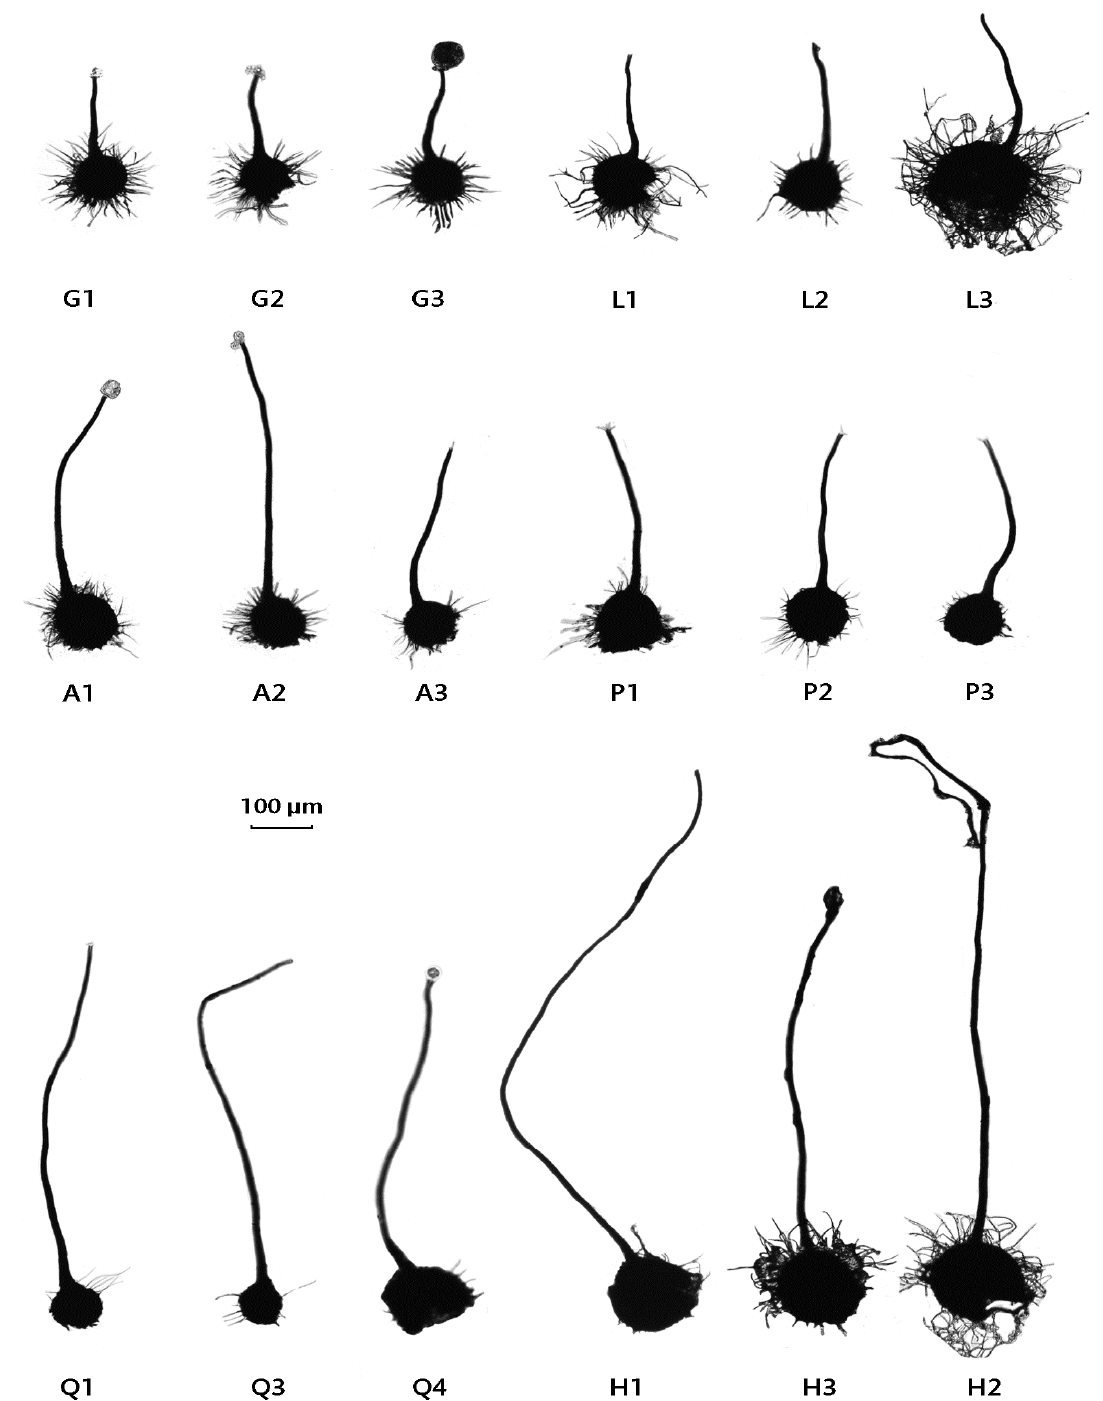
Figure 5. Perithecia of Orvieto and Limburg hybrids. Top row, random perithecia of short-necked, more SSAM-like Limburg and Orvieto pairings, G and L, respectively; Middle row, random perithecia of more SSNU-like Limburg and Orvieto pairings, A and P, respectively; bottom row, random perithecia of extreme long necked Orvieto and Limburg pairings, Q and H, respectively. Scale bar = 100 µ m. Some perithecial bowls are adorned with setae. Dark droplets at the tips of some necks are extruded ascospore masses. Parings: G, isolates NL10 × NL4; L, I366 × I368; A, Nl20 × NL52; P, I366 × I341; Q, I345 × I343; H, NL36 × NL51. See also Figures 4 and 6.